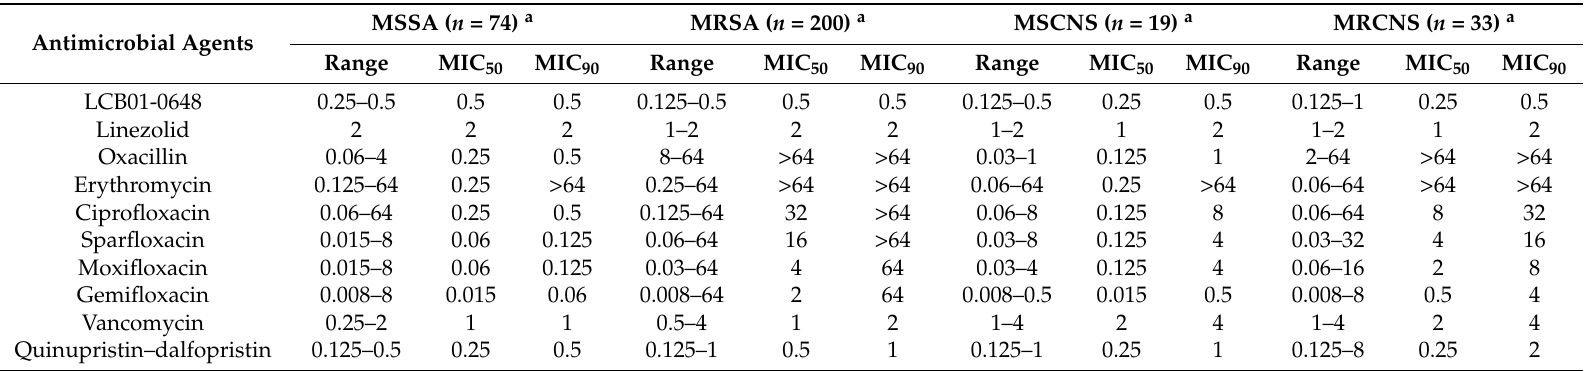
Table 1. Minimum inhibitory concentrations (MICs) of LCB01-0648, linezolid, oxacillin, erythromycin, ciprofloxacin, sparfloxacin, moxifloxacin, gemifloxacin, vancomycin, and quinupristin–dalfopristin for clinical isolates of Staphylococci.